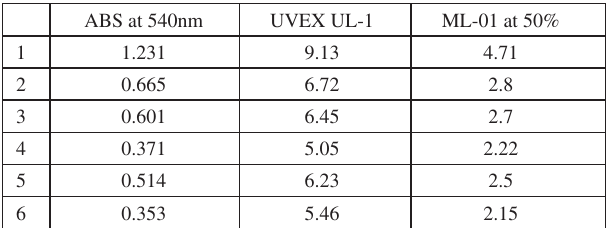
Table 1. The measurement of anthocyanin content in 6 randomly selected sour cherry varieties by spectrophotometer (ABS), by Uvex LB-1 and Uvex ML-1 (Újfehértó, 2009) ABS at 540nm